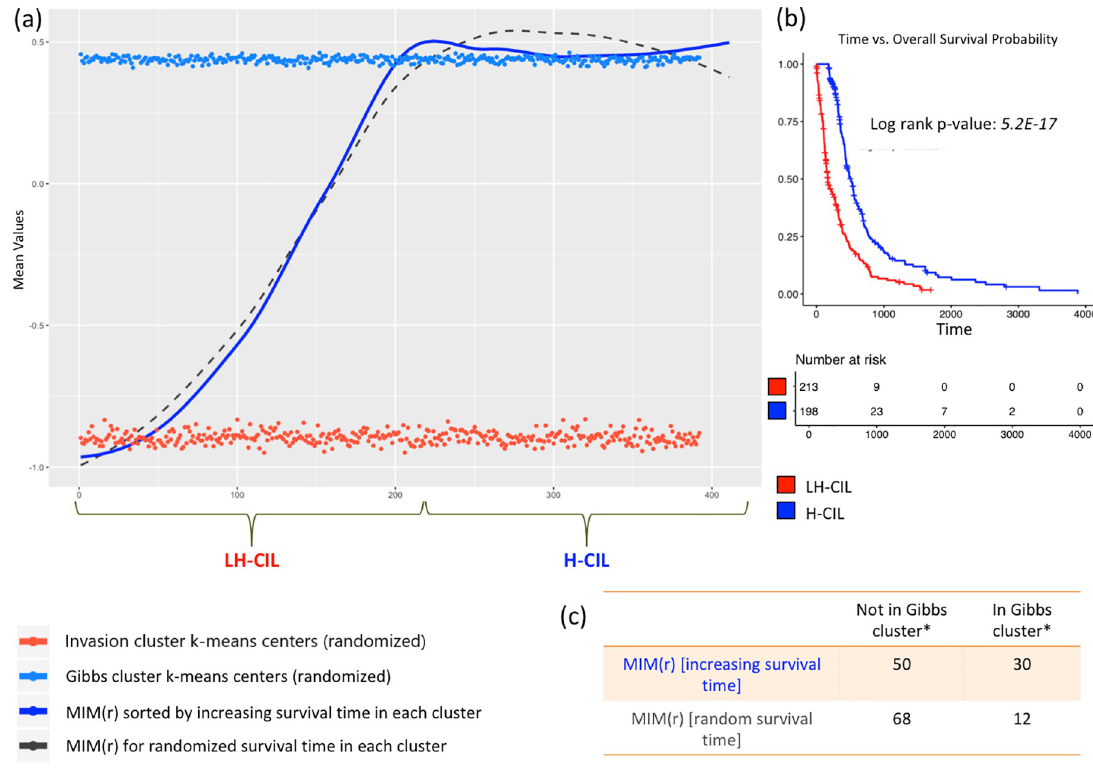
Fig 3. Survival time